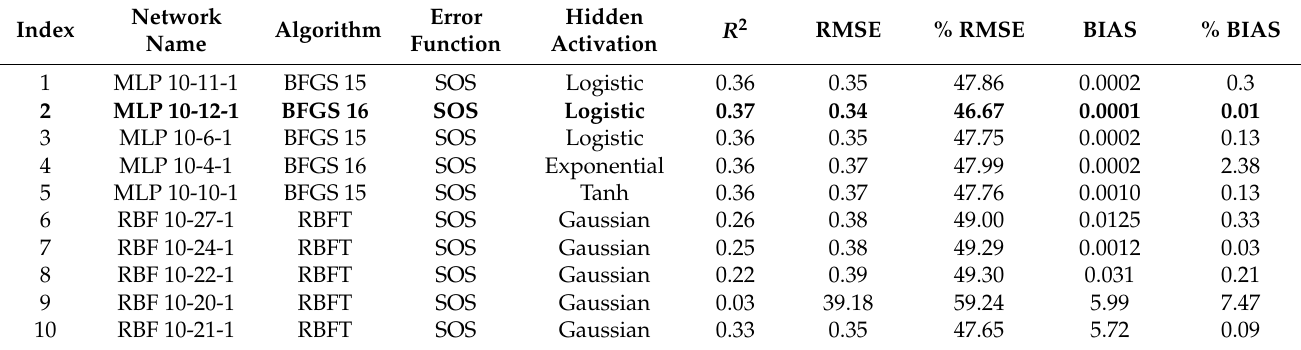
Figure 10. Relationship between predicted and actual net annual volume growth (productivity) by (Poisson regression (red line) and nonparametric methods (ANN (black line)). When using the ANN, a minimum of 4 layers and a maximum of 27 hidden layers were used. The results show that when 12 hidden layers were used, the highest accuracy can be estimated (Tables 5 and 6). While the RMSE and bias were low, MLP ‐ based ANNs and RBF ‐ based models had moderately good coefficient of determination values ( R 2 = 0.34 for the selected model), indicating that a fair linear relation existed between the actual measured net annual volume growth and the predicted net annual volume growth. Table 5. Characteristics of RBF and MLP ‐ based ANNs and associated metrics for productivity model training.